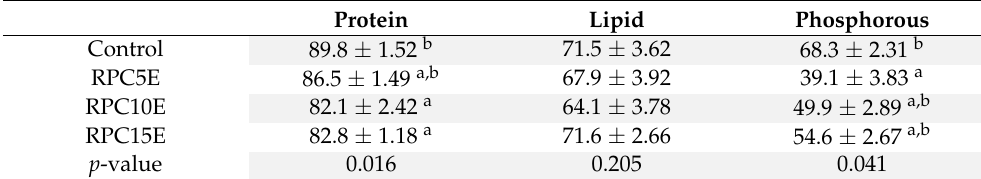
Table 5. ADC of protein, lipid and phosphorus